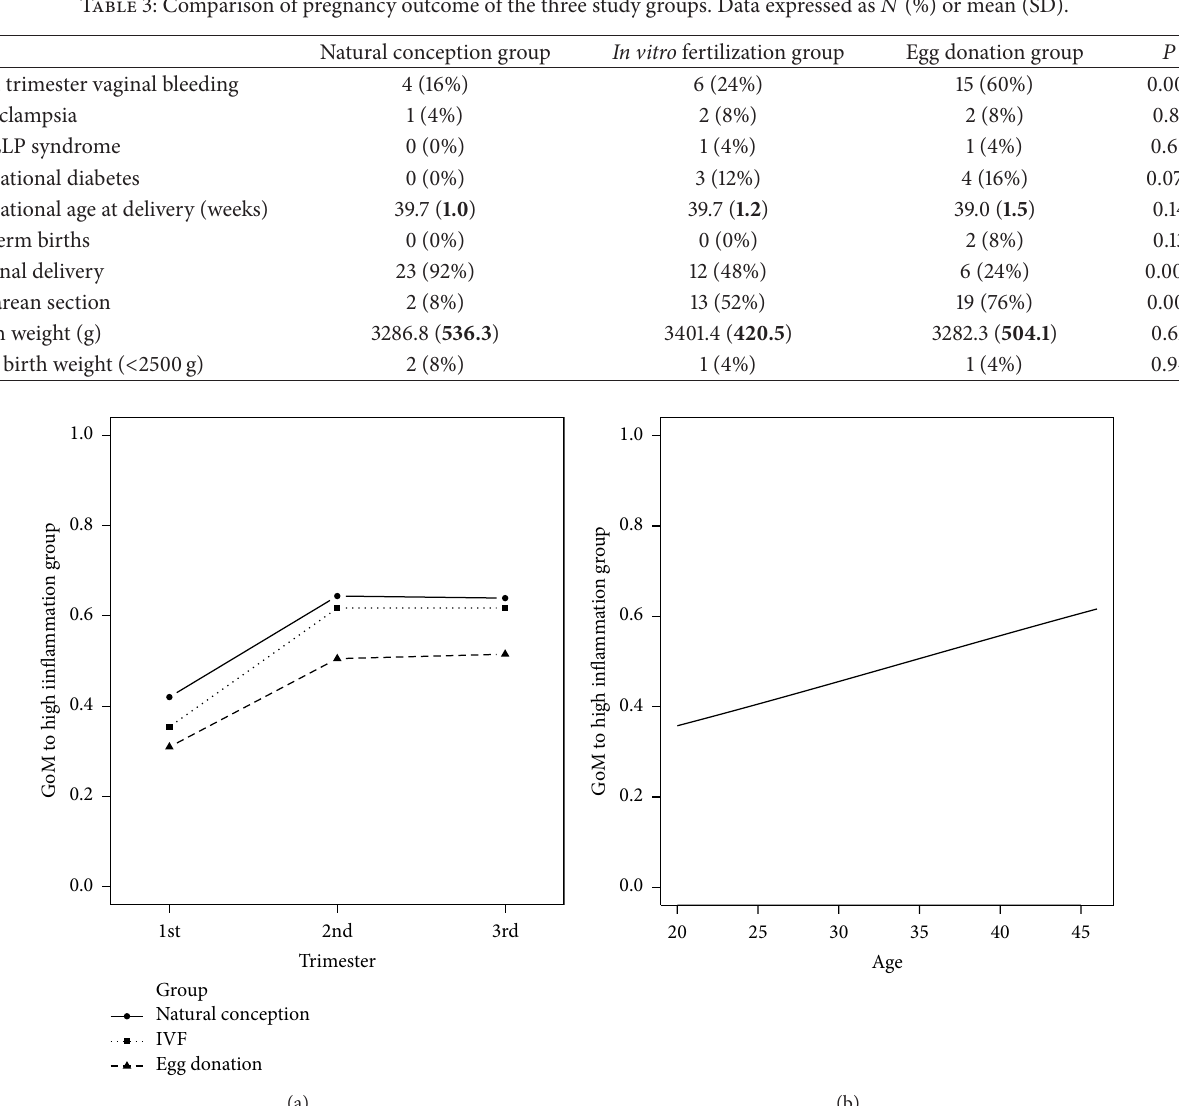
Figure 4: Effect plots for our beta regression mixed model results. (a) The three groups showed the same trend: their GoM (grade of membership) values increased in the second trimester and remained high in the third trimester. (b) A positive association between maternal age and GoM